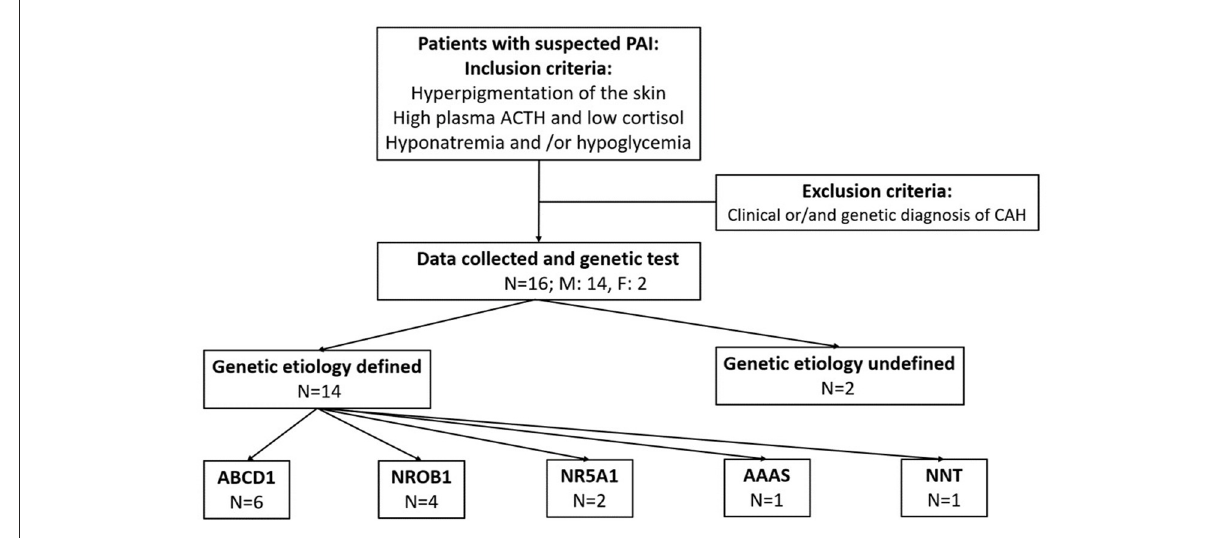
FIGURE1 Study design, recruitment and genetic results.